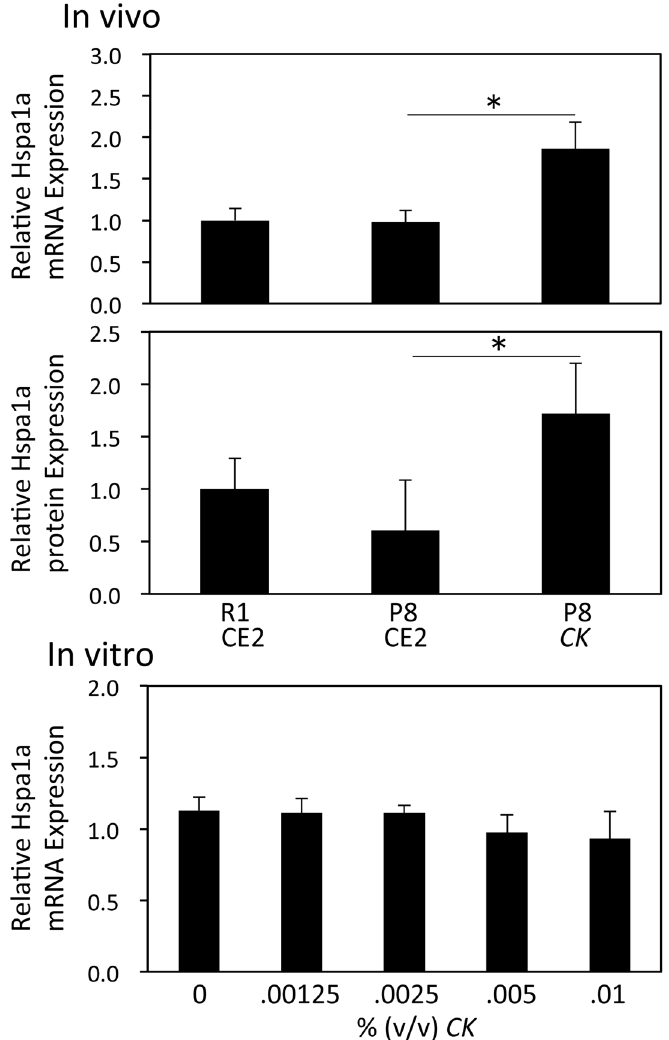
GAPD mRNA were evaluated using quantitative real-time PCR. Results are presented as the relative HSPA1A mRNA level (HSPA1A/GAPD). HSPA1A protein expression in brain homogenates was